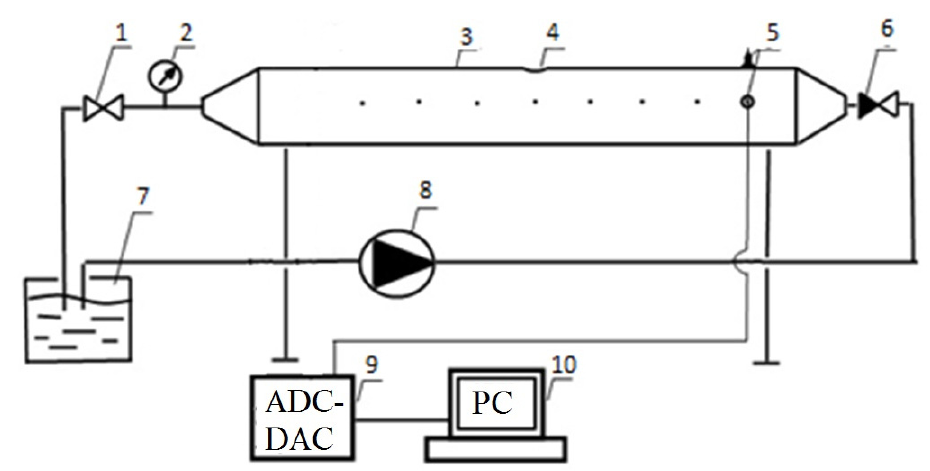
Figure 1. Experimental stand: ( 1 ) valve; ( 2 ) pressure gauge; ( 3 ) pipeline; ( 4 ) defect; ( 5 ) piezoelectric transducer; ( 6 ) check valve; ( 7 ) capacity; ( 8 ) pump; ( 9 ) ADC-DAC; ( 10 ) computer.